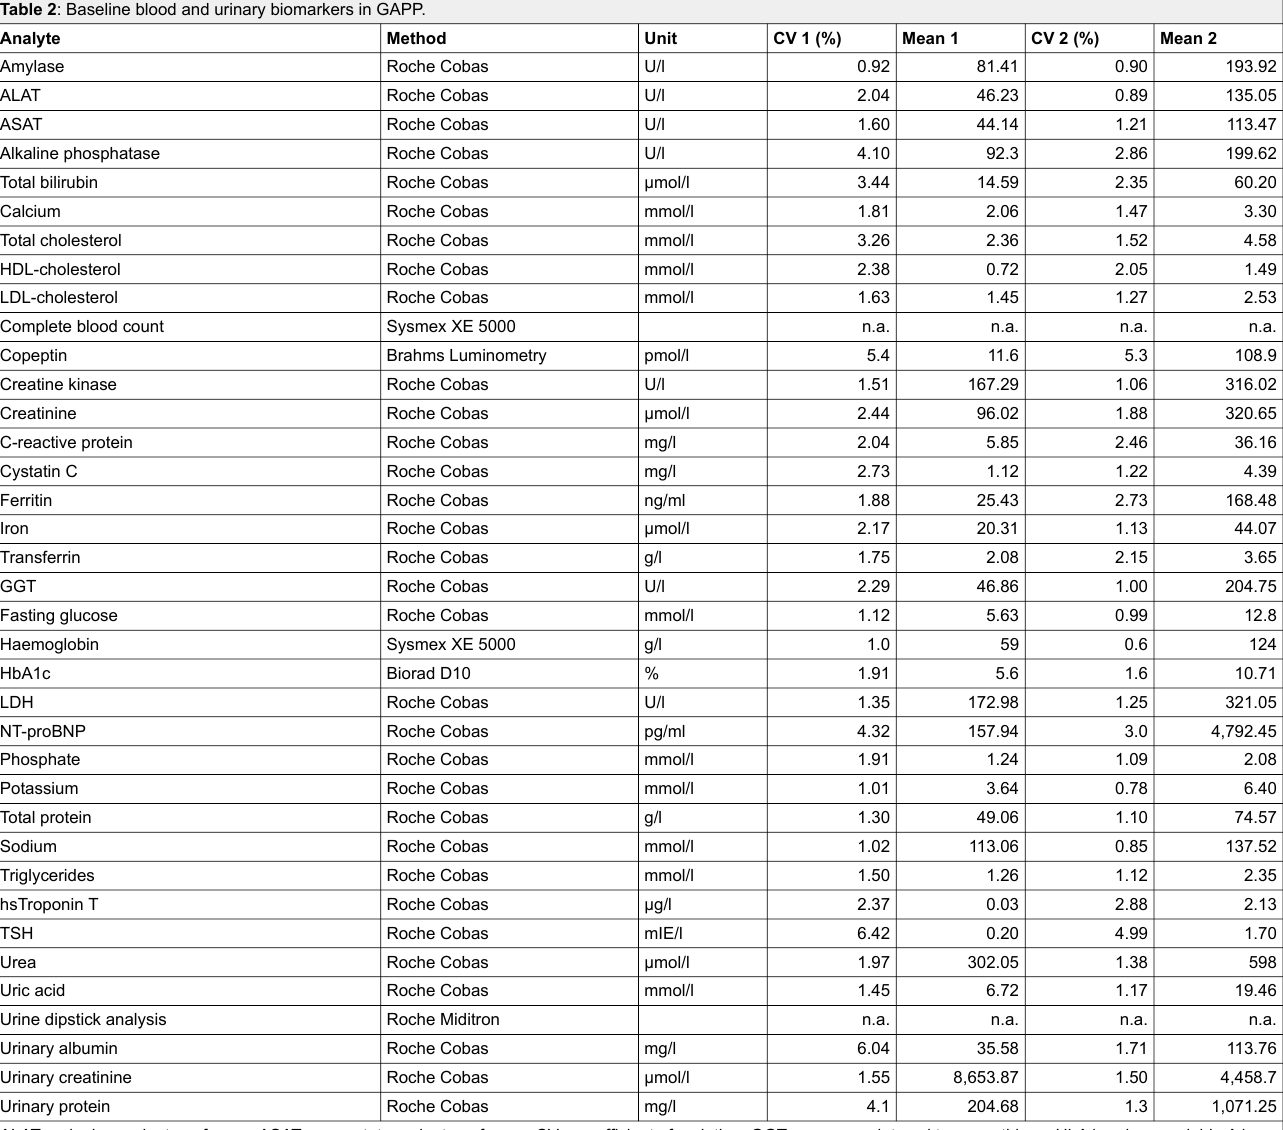
Table 2 : Baseline blood and urinary biomarkers in